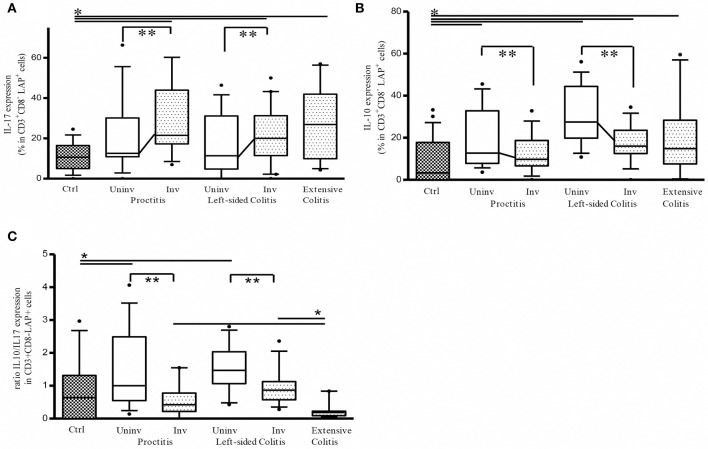
Ratio between IL-10 and IL-17 expressing CD3+CD8-(CD4)LAP+ cells is significantly higher in uninvolved (Uninv) vs. involved (Inv) colon tissue from ulcerative colitis patients. (A) Frequency of LP LAP+ cells expressing intracellular IL-17 *P < 0.05 (Mann-Whitney U-test) for controls vs. Involved (Inv) tissue in proctitis, left sided colitis and extensive colitis. **P < 0.05 (Wilcoxon signed-rank test) for uninvolved vs. involved tissue in both proctitis and left-sided colitis. (B) Frequency of LP LAP+ cells expressing intracellular IL-10: *P < 0.05 (Mann-Whitney U-test) for controls vs. proctitis (Uninv), left-sided colitis (Uninv + Inv), and extensive colitis; **P < 0.05 (Wilcoxon signed-rank test) for uninvolved vs. involved tissue in both proctitis and left-sided colitis. (C) % LP LAP+ cells expressing intracellular IL-10 / % LP LAP+ cells expressing intracellular IL-17 (ratio). **P < 0.05 (Wilcoxon signed-rank test) for uninvolved vs. involved tissue in proctitis, and left sided colitis. *P < 0.05 (Mann-Whitney U-test) proctitis and left-sided colitis univolved tissue vs. controls *P < 0.05 (Mann-Whitney U-test) Extensive colitis vs. proctitis and vs. left-sided colitis involved tissue. Data represent mean ± SE of 43 UC patients (proctitis, 16; left-sided colitis, 17; extensive colitis, 10) and 26 controls.